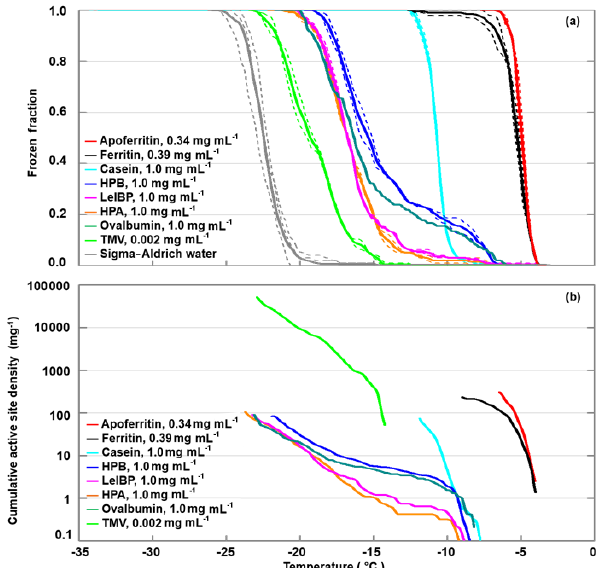
Figure 2. DRINCZ experiments performed with apoferritin (0.34mgmL − 1 , batch 1), ferritin (0.39mgmL − 1 , batch 1), ca- sein (1.0mgmL − 1 ), HPA (1.0mgmL − 1 ), HPB (1.0mgmL − 1 ), LeIBP (1.0mgmL − 1 ), ovalbumin (1.0mgmL − 1 ), and TMV (0.002mgmL − 1 ). (a) Frozen fraction as a function of temperature. For comparison, freezing of pure SA water is also shown. Single- freezing runs are shown as dashed lines and the mean as the thick solid lines. (b) Cumulative active site densities.